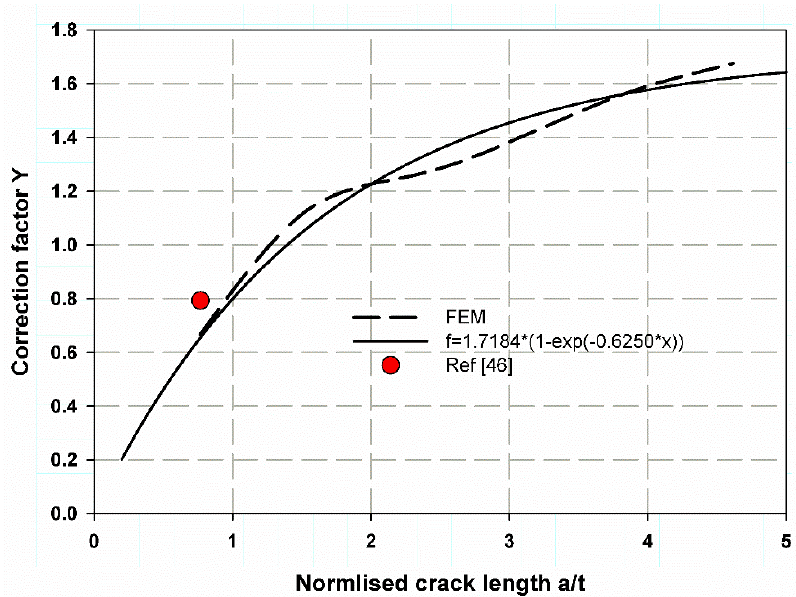
Figure 17. Correction factor for an unmovable crack through-thickness of walled composite cylinder.